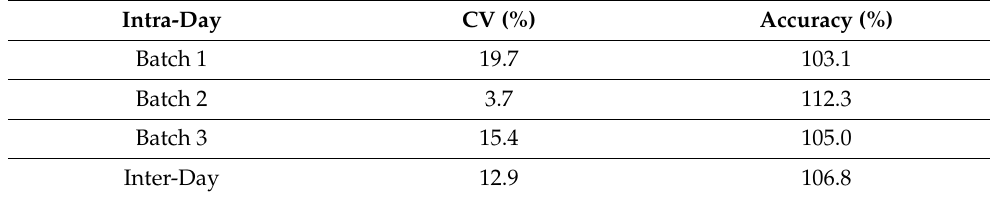
Table 1. Accuracy and precision for LLOQ (nominal concentration: 0.2 µg/mL).